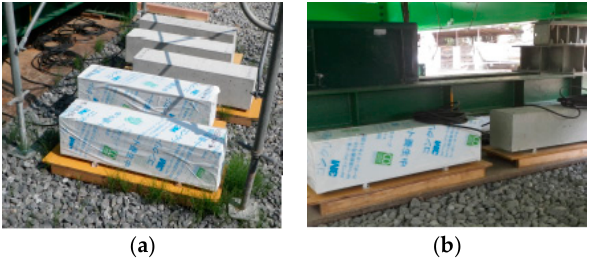
Figure 4. ( a ) Specimens with direct rainfall exposure; ( b ) shaded specimens.